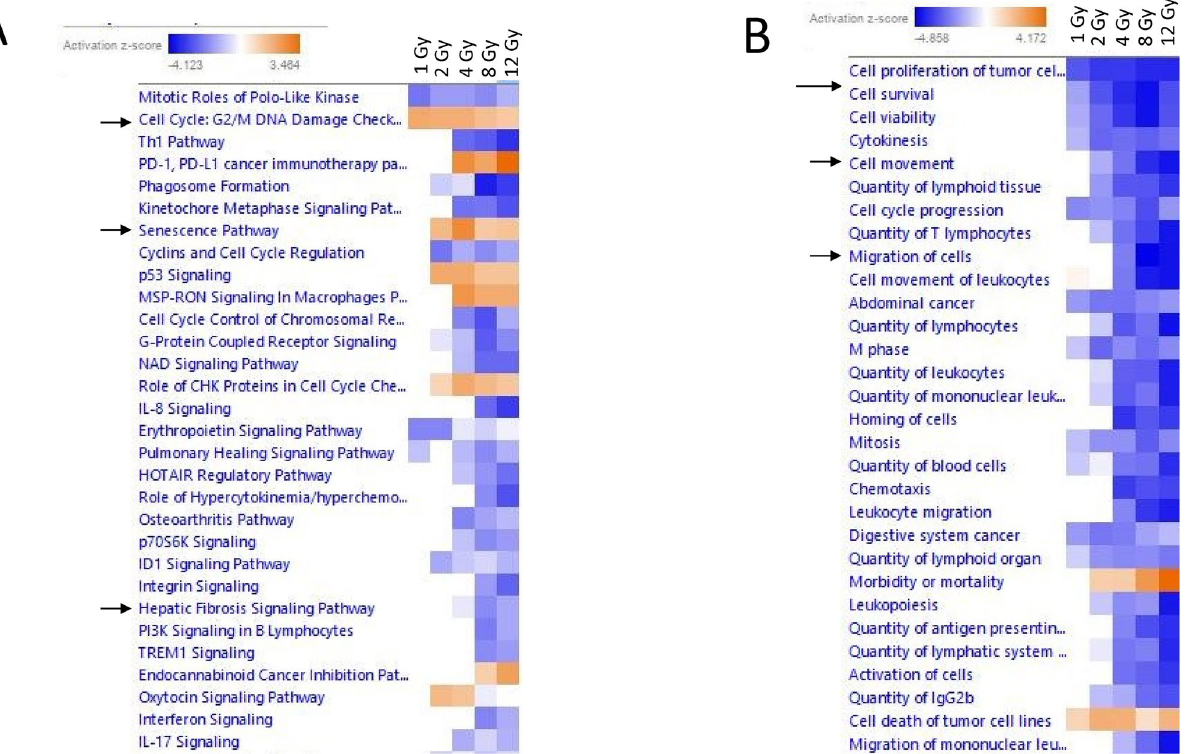
Figure 2. Predicted canonical pathway dysregulation in mouse liver samples based on all differentially expressed mRNAs. IPA was used to perform pathway analysis on all differentially expressed mRNAs to predict pathway involvement, independent of the target relationship with differentially expressed miRNAs. ( A ) Displays the top 30 most significantly dysregulated pathways (B-H p value < 0.05). A positive z-score indicates predicted activation of the pathway based on gene expression and a negative z-score indicates predicted deactivation of the pathway based on gene expression. Pathways are hierarchically clustered by z-score. ( B ) Displays top 30 most dysregulated functions (B-H p value <